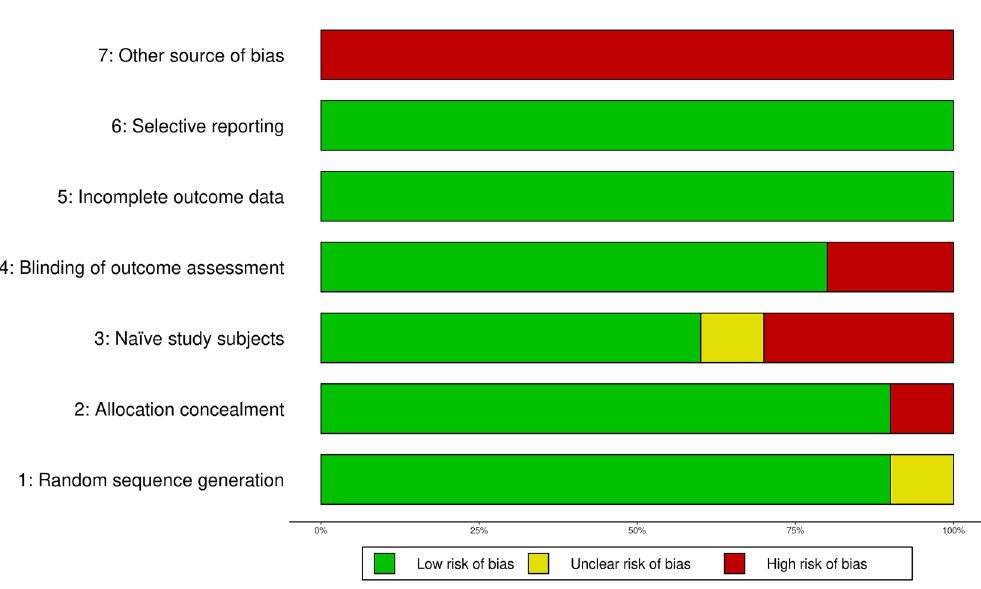
Figure 3. Risk of bias for each item across 10 studies included in a systematic review comparing the outcome of applying spinal manipulative therapy at a candidate site versus a non-candidate site. The risk of bias was assessed using a modified version of the Cochrane Risk of Bias Tool for Randomized Controlled Trials. ‘Green’ indicates low risk of bias, ‘red’ indicates high risk of bias, and ‘yellow’ indicates an unsure risk of